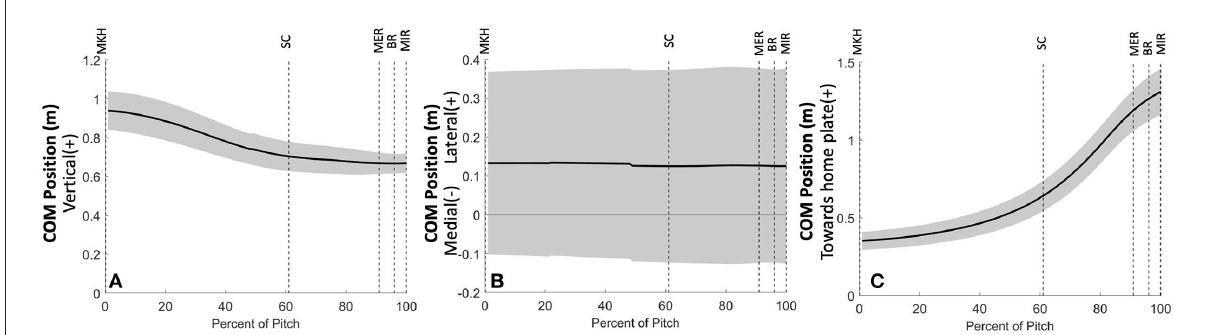
FIGURE13 Mean ± SD center of mass position along the vertical (A) , mediolateral (B) , and anterior-posterior (towards home plate; C ) global coordinate axes for the 3 fastest pitches thrown for strikes from 23 developmental-aged pitchers for the duration of the pitch from maximum knee height (MKH) to maximum internal rotation (MIR).